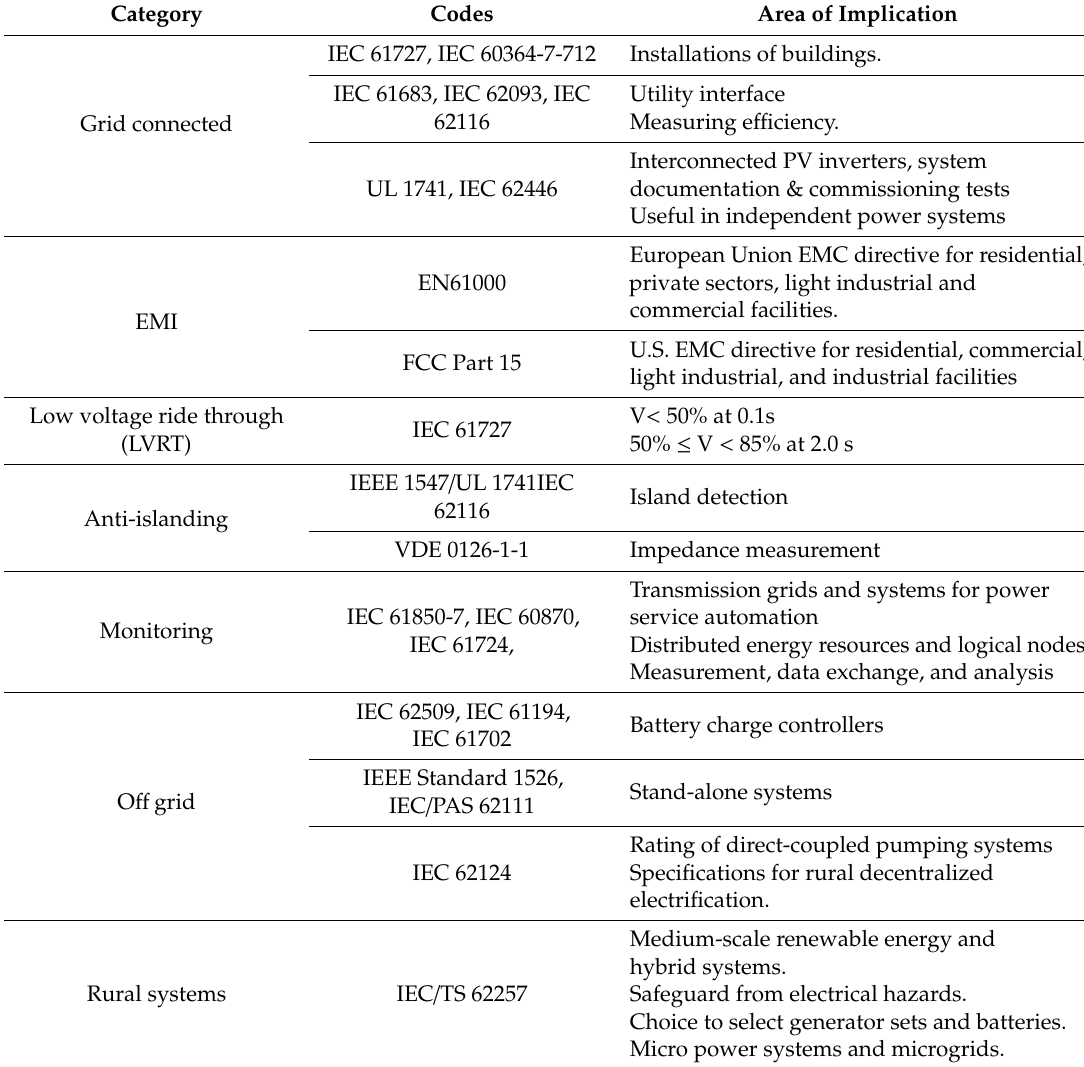
Table 6. A Summary of International codes for PV